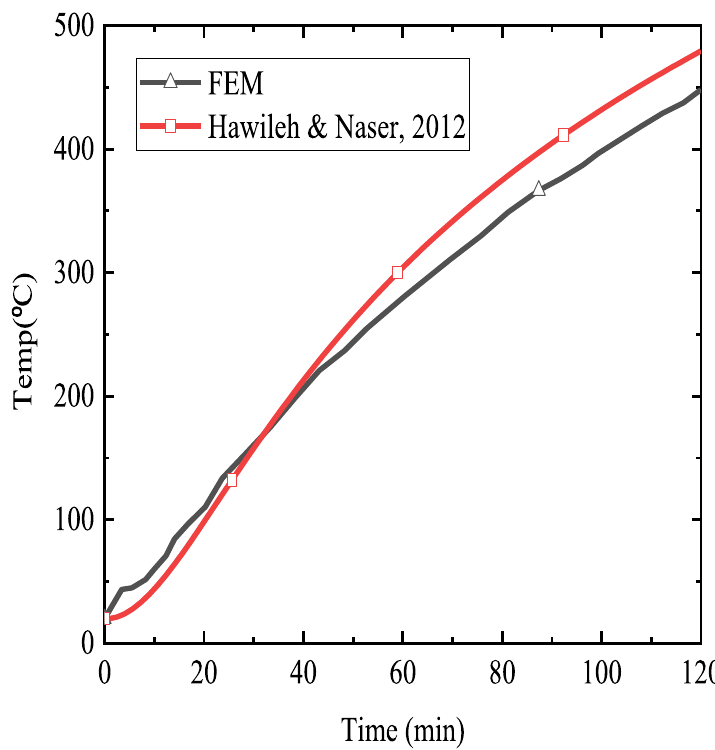
Fig. 33 Temperature distribution on GFRP. a Load-displacement curve. b Crack distribution at 2% drift in test. c Crack distribution at 2% drift in